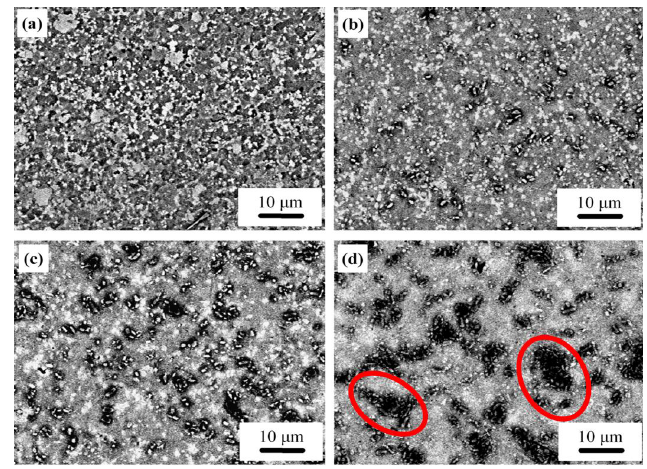
Figure 1. Scanning Electron Microscopy (SEM) images of hot extruded Al-12Si/Al 2 O 3 nanocomposites with ( a ) 0, ( b ) 2, ( c ) 5, and ( d ) 10 wt. % reinforcement.